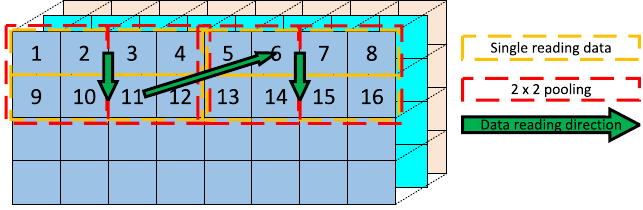
Figure 5. Pooling layer parallel computing